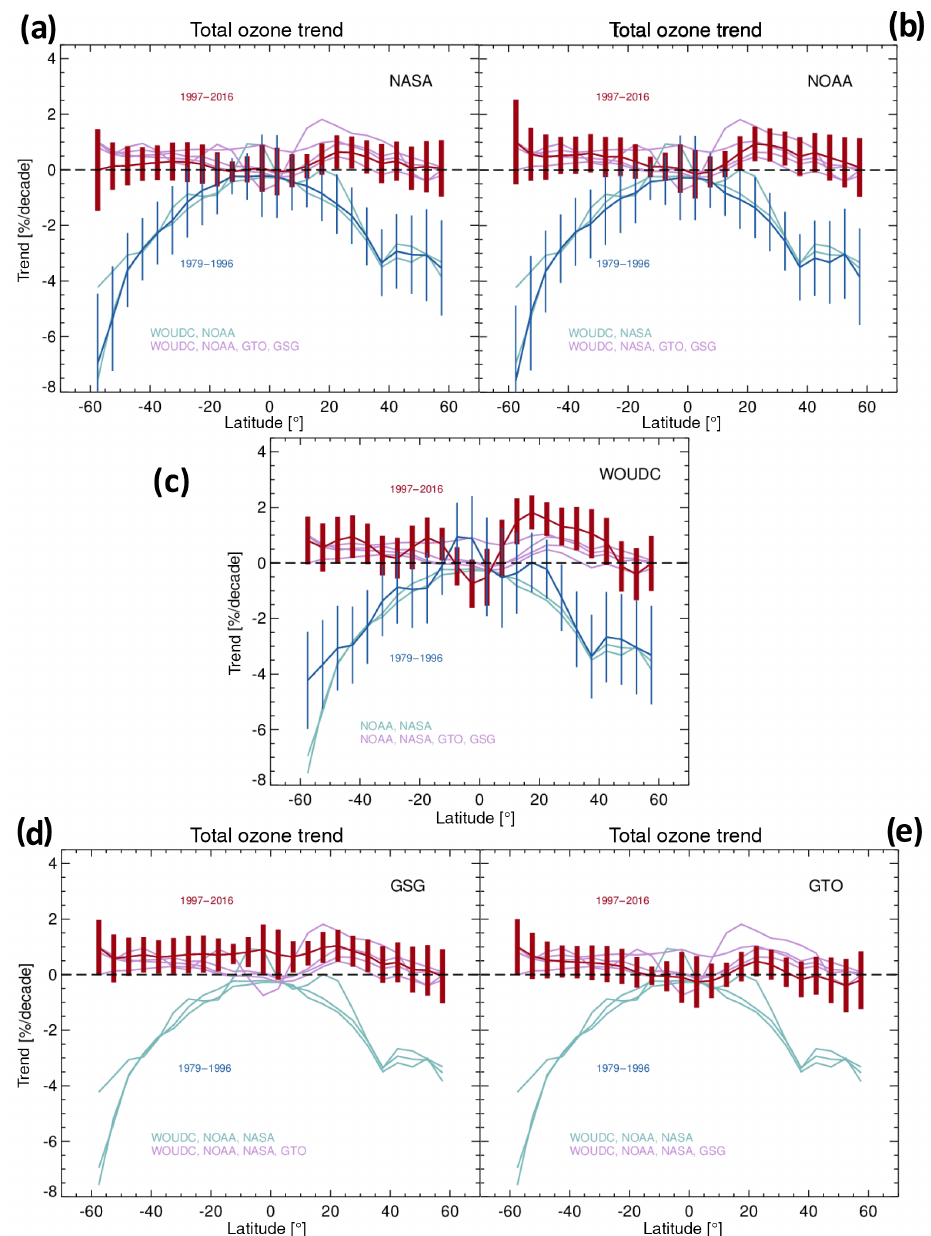
Figure 7. Linear trends and in %decade − 1 and 2 σ uncertainty bars before (red) and after (blue) year 1996. (a) NASA SBUV, (b) NOAA SBUV, (c) WOUDC, (d) GSG, and (e) GTO. Trends were calculated in 5 ◦ zonal bins from 60 ◦ S to 60 ◦ N using the full regression model. In panels (d) and (e) , the trends before the pre-ODS peak are not shown as the GSG and GTO are mainly available after 1995. In light colors (red and blue), trends from all datasets are overlaid in each panel to facilitate comparison.